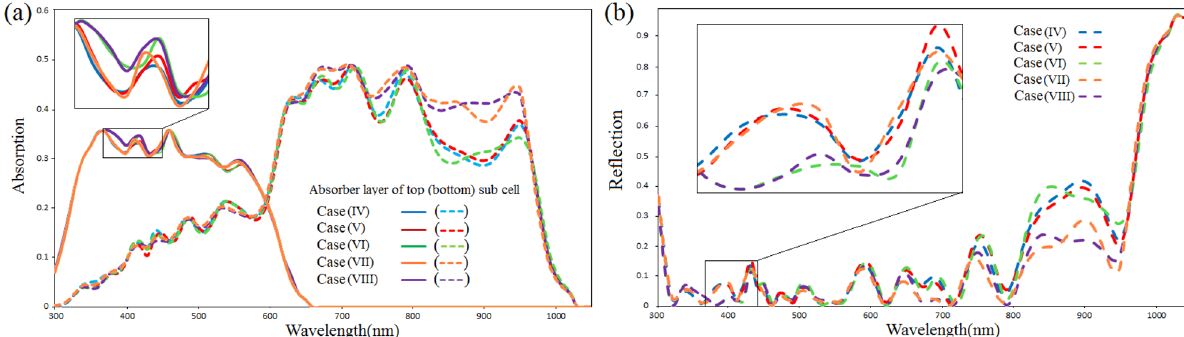
Figure 10. The spectrum of the top and bottom sub cells absorption and total reflection of the proposed cases